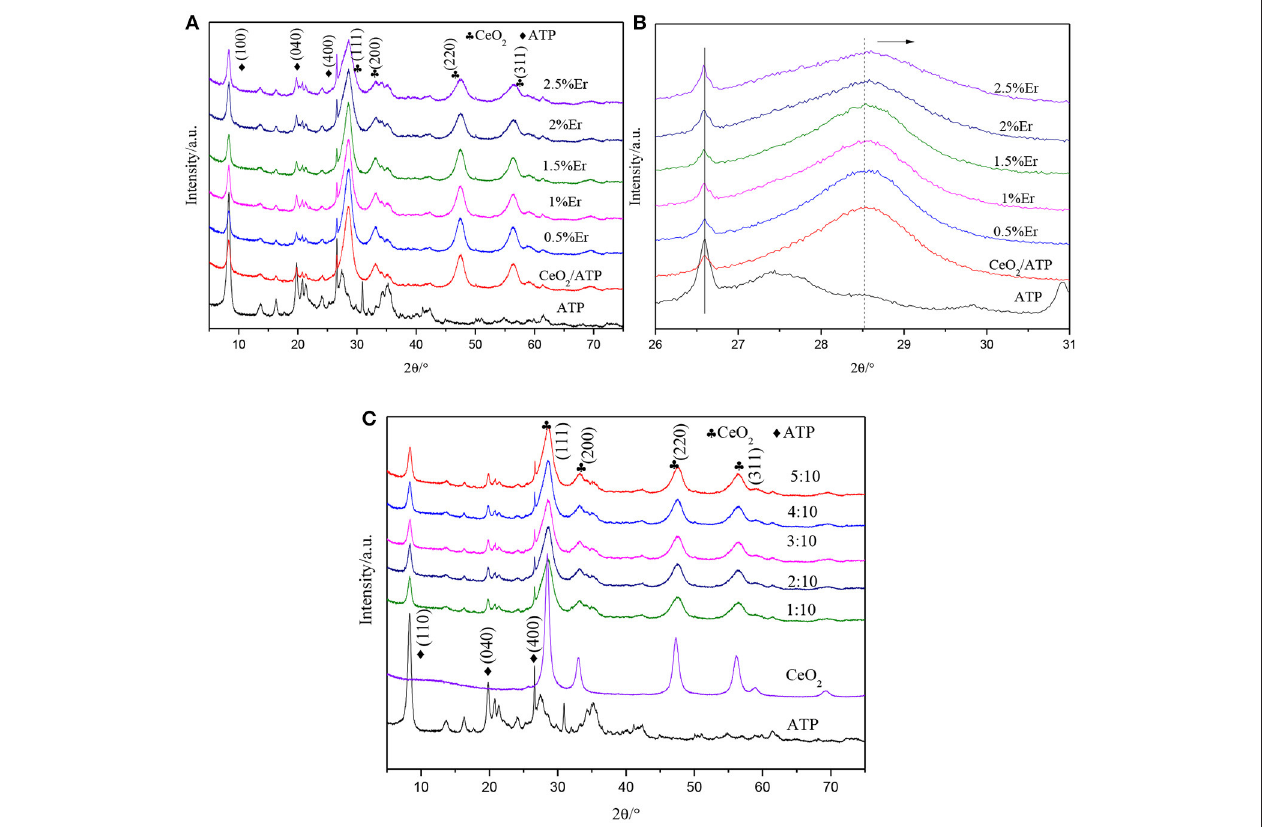
FIGURE 1 | XRD patterns of ATP, CeO 2 /ATP and Er 3 + :CeO 2 /ATP with various molar fractions of Er doping (A) , the enlarged diffraction peak from 26 to 31 ◦ (B) , and different mass ratio of Er 3 + :CeO 2 to ATP (C) .